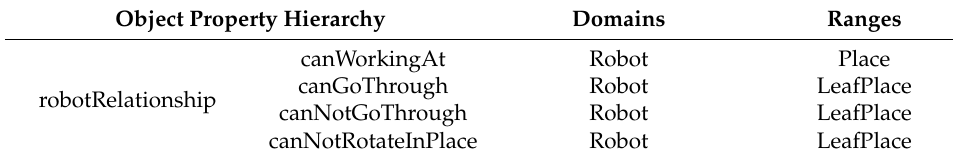
Table 3. Object properties for Robot . Object Property